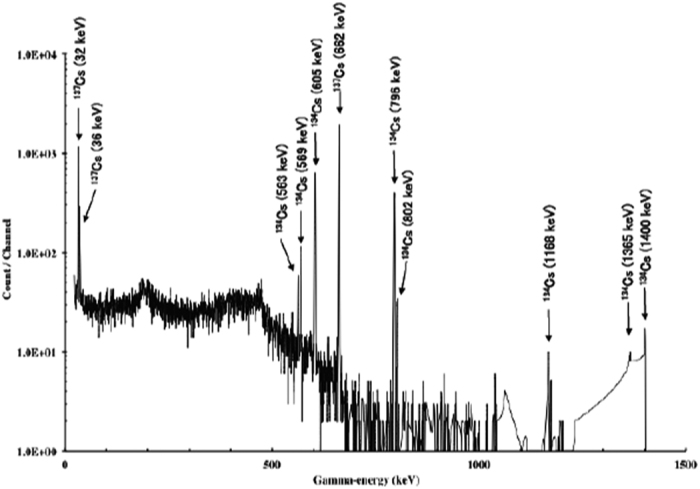
Typical gamma-ray spectrum taken from the samples in Okuma.